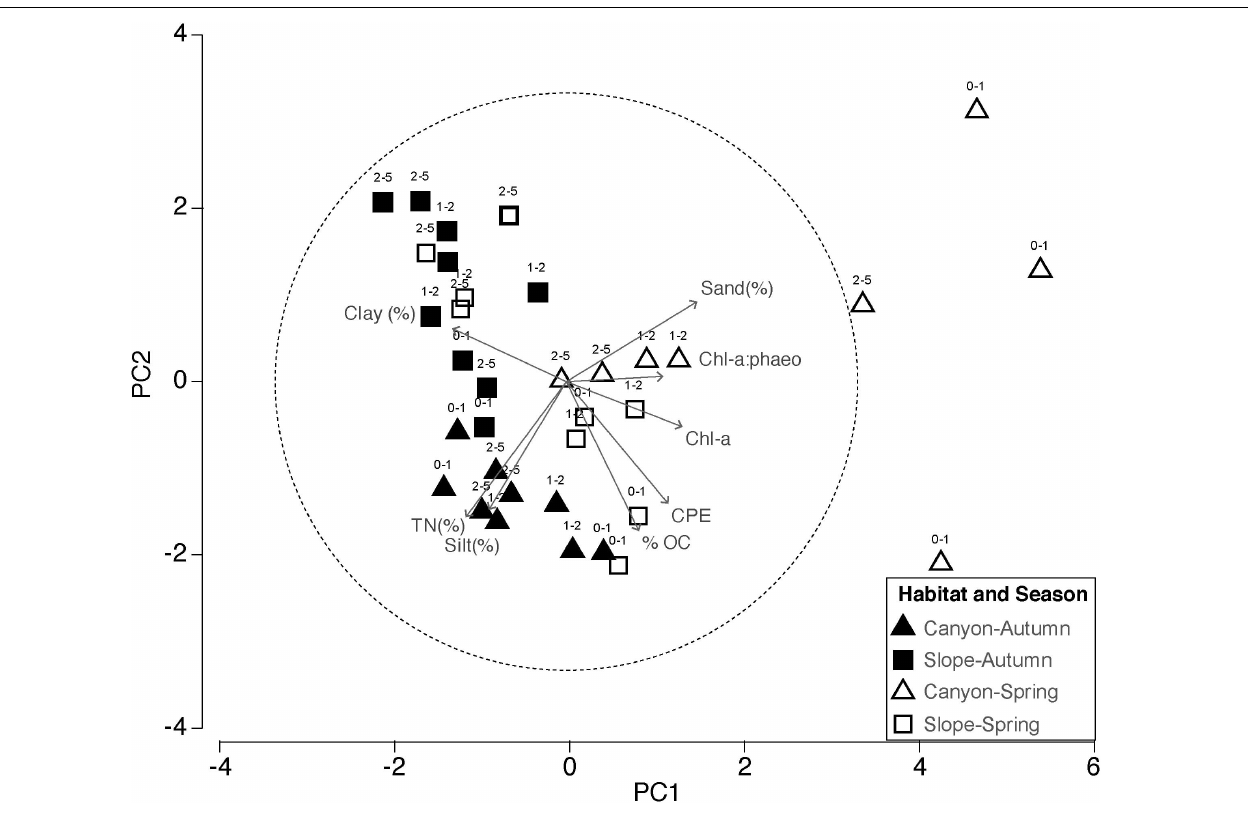
FIGURE 3 | Principal component analysis (PCA) ordination based on selected environmental variables at the studied stations. Parameters included in the analyses were: clay (%), silt (%); sand (%), organic carbon (OC), total nitrogen (TN), chlorophyll a (chl a ), chloroplast pigments equivalents (CPE), chlorophyll a: phaeopigment ratio (chl a :